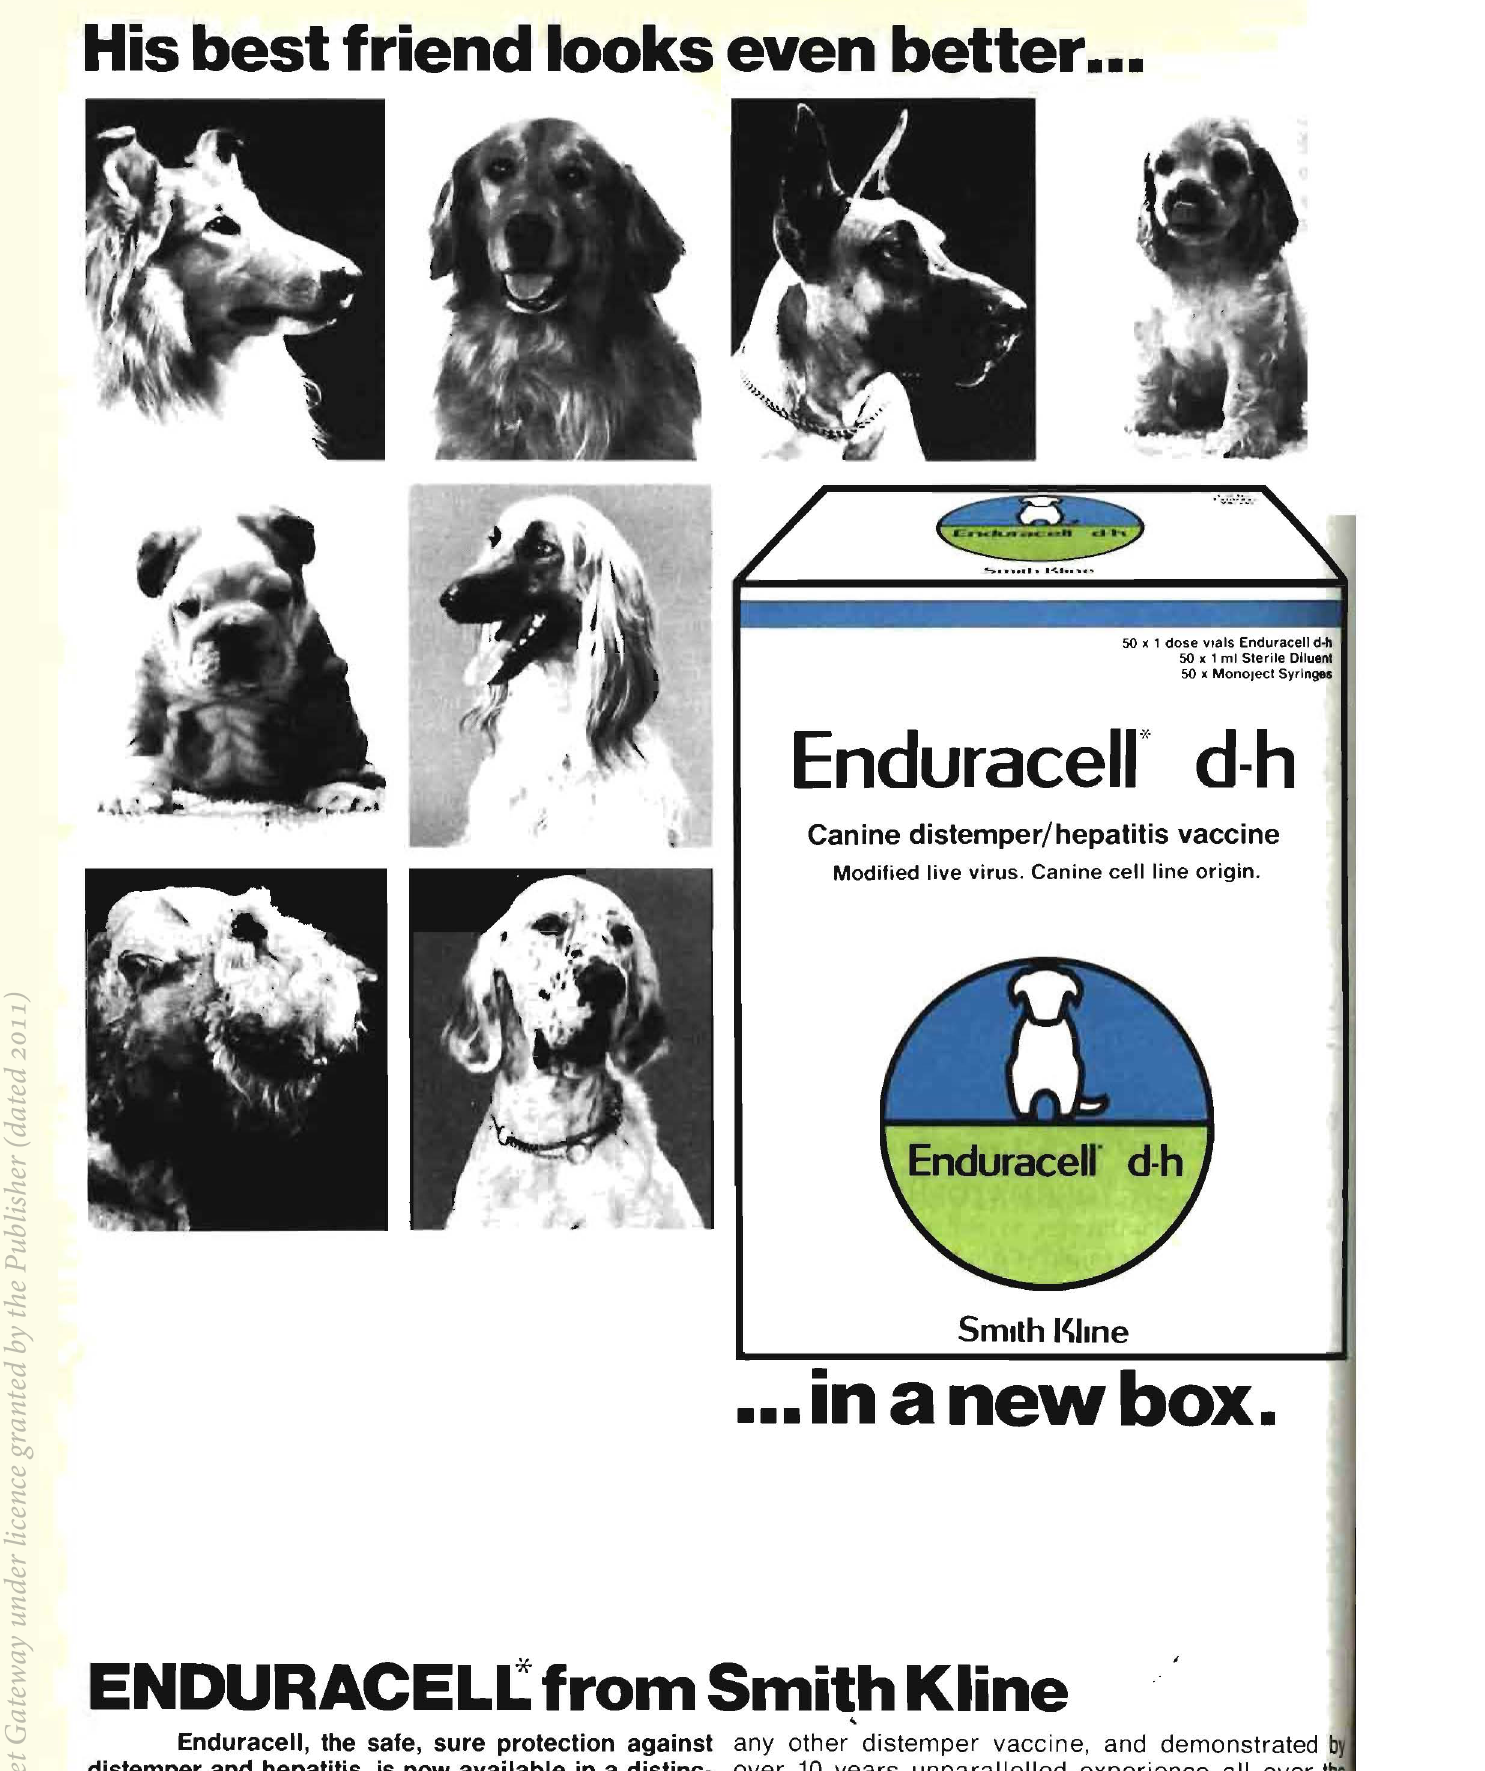
Enduracelr d-h Canine distemper/hepatitis vaccine Modified live virus. Canine cell line